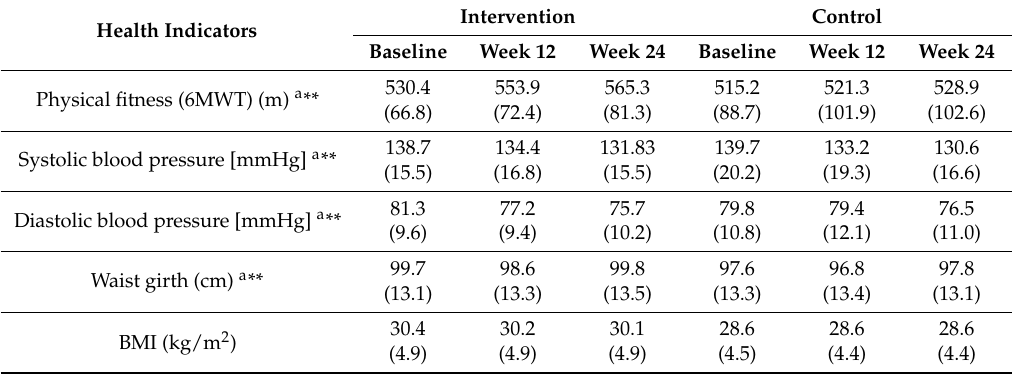
Table 4. Health variables for intervention and control groups at baseline, week 12, and follow-up. Health Indicators